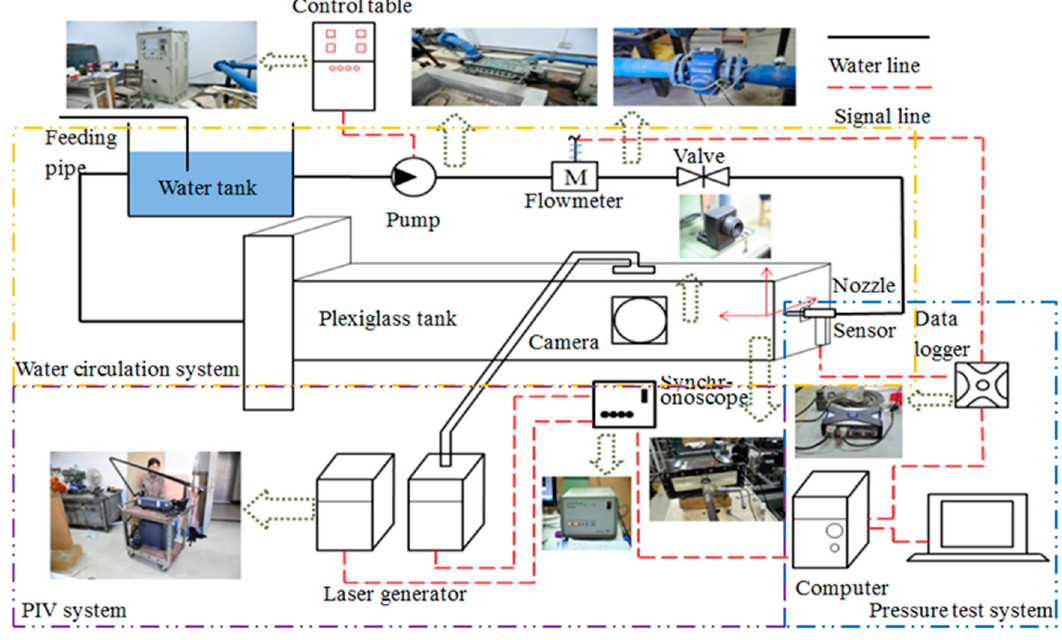
Figure 1. Schematic diagram of the experimental setup.